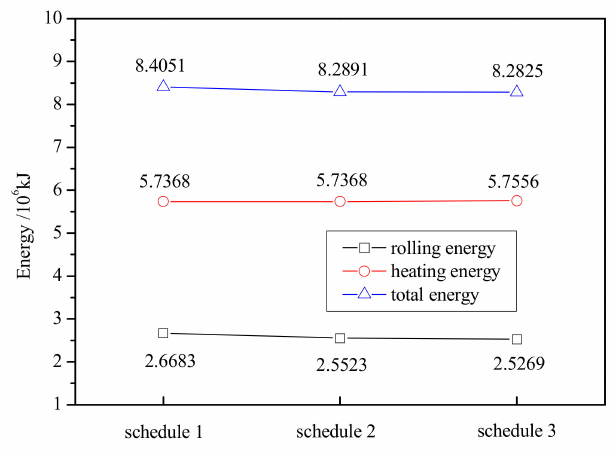
Figure 8. Comparison of heating energy, rolling energy and total energy of three